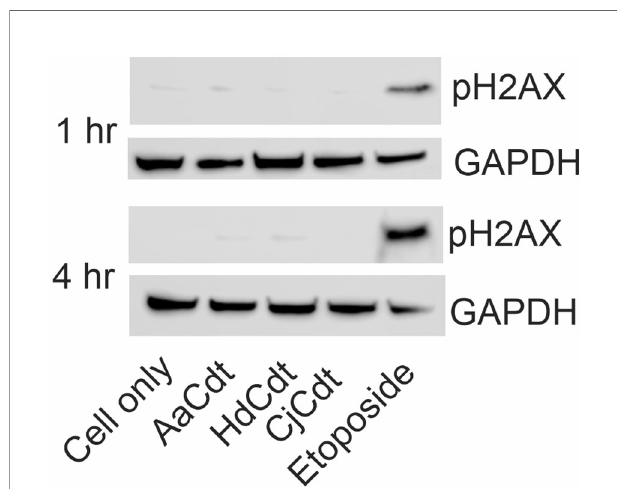
FIGURE 5 | Comparison of the effects of AaCdt, HdCdt, and CjCdt on phosphorylation of H2AX. Jurkat WT cells were incubated in the presence AaCdt, HdCdt, and CjCdt (same concentrations as above) for one and four hrs. Cells were then fractionated and analyzed by Western blot for the presence of pH2AX. Etoposide-treated cells were used as a positive control. A representative blot of three experiments is shown.